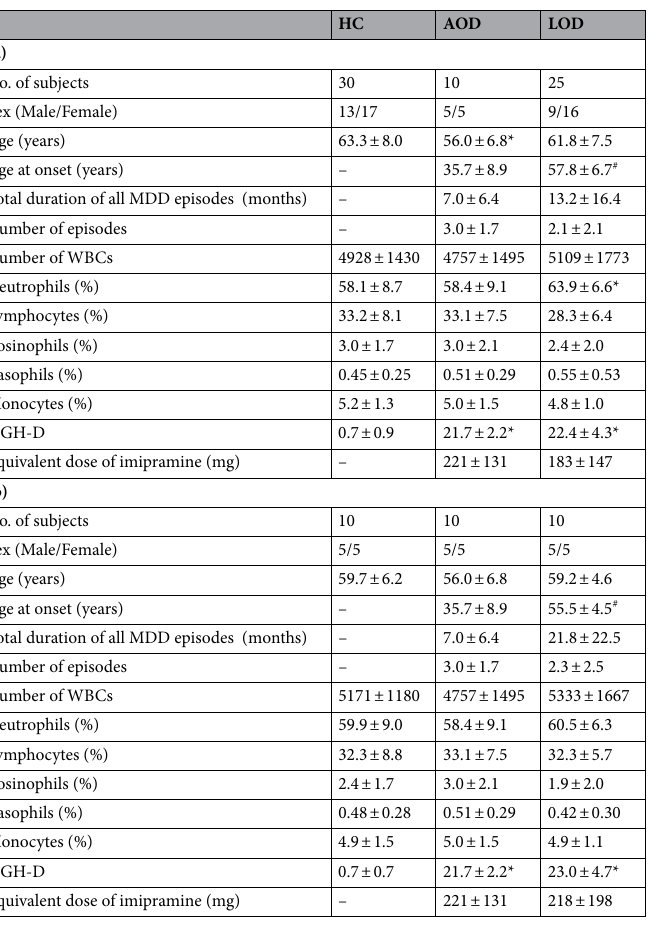
Table 1. Participants’ demographics and characteristics in Group 1a and 1b (discovery and training samples, respectively). Characteristics of the participants for the genome-wide methylation array ( a ) and for the validation using pyrosequencing and amplicon bisulfite sequencing ( b ). Statistical analyses performed using the EZR software (version 1.37) (http://www.jichi .ac.jp/saita ma-sct/Saita maHP.files /statm edEN.html). Data are shown as the mean ± standard deviation. *p < 0.05 compared to HC. # p < 0.05 compared to AOD. AOD,